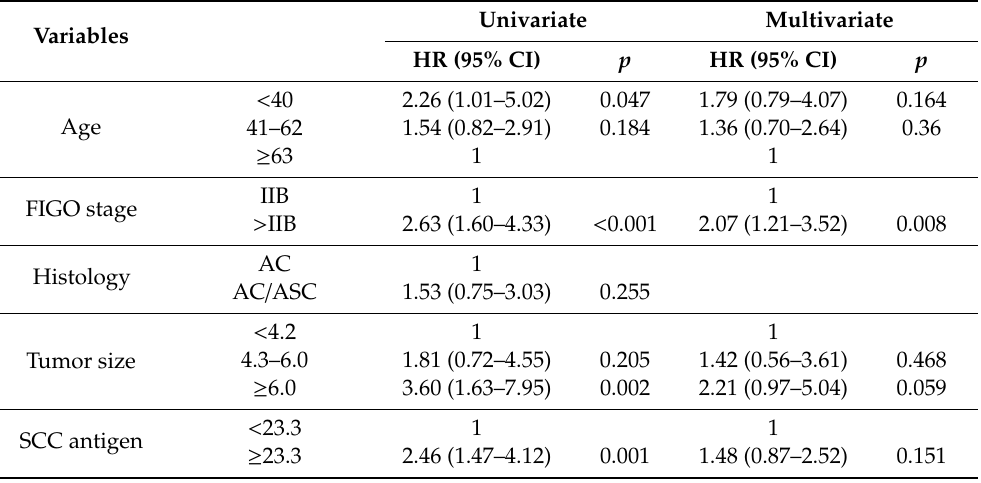
Table 3. Hazard ratio by Cox’s proportional hazards model for risk factors of